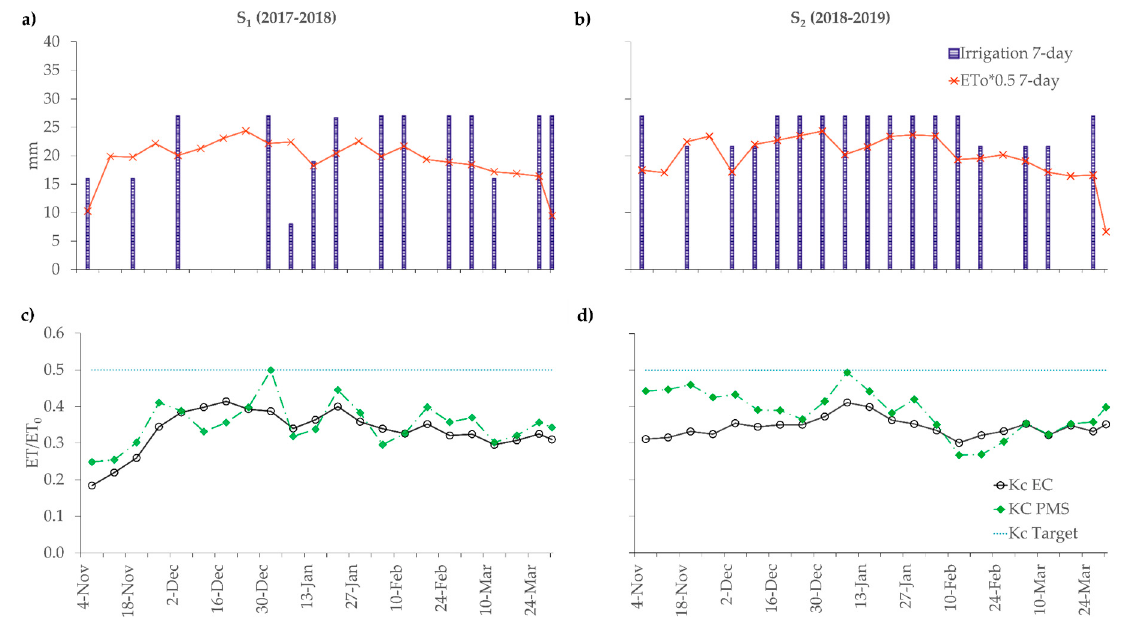
Figure 10. ( a , b ) Irrigation schedule during S 1 (2017–2018) ( a ) and S 2 (2018–2019) ( b ) in 7-day cumulative intervals, total amount of water applied in mm (7-day irrigation) and total programmed irrigation in mm according to the criteria of crop coefficient (Kc) equal to 0.5 (ET 0 × 5 7-day). ( c , d ) Comparison of the Kc = 0.5 (Kc Target) with the estimated Kc with data from both the eddy covariance system (Kc EC = ET EC/ETo) and the Penman-Monteith model for remote sensing coupled to Stewart’s stomatal conductance model (Kc PMS = ET PMS/ETo) during seasons S 1 ( c ) and S 2 ( d